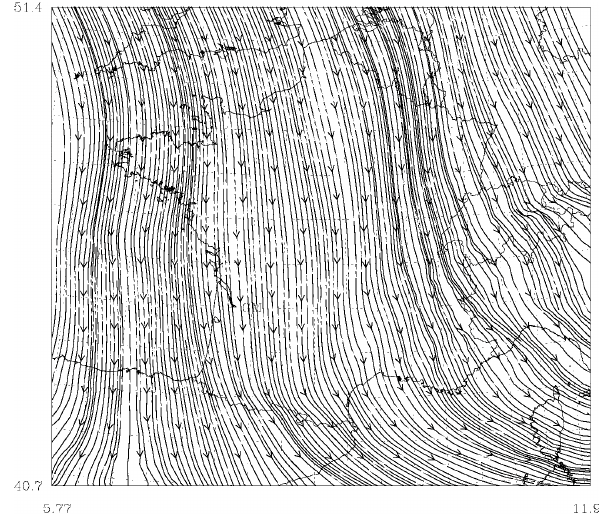
Fig. 12. Stream field at 18:00UTC simulated by Meso-NH at the nearest model level from